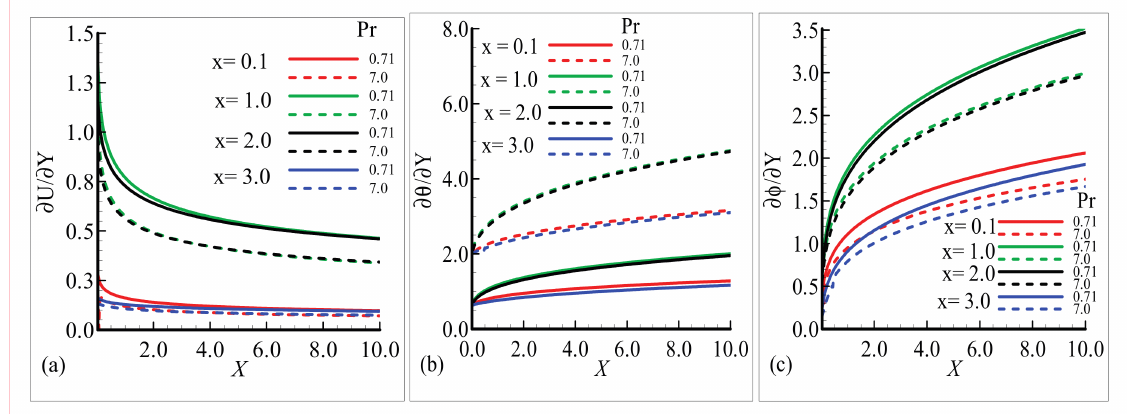
Figure 8. Physical e ff ects on quantities ( a ) ∂ U ∂ Pr = 7.0, M = 0.2, Q = 1.0.